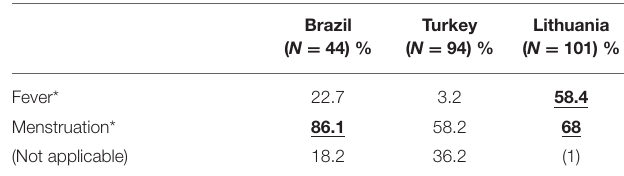
Statisticalcalculationsweredoneamongthosewhowereexposedtomodulatoryfactors. The rates show provocation rates unless otherwise stated. The bold and underlined ones are statistically significant rates according to adjusted residual ( ≥ 2) values and p-value ( < 0.05) in Pearson chi-square. The italic and underlined ones are meaningful according to adjusted residuals and p-values ( < 0.05) in chi-square, but not the rates in which the number of individuals are < 15. Audit,